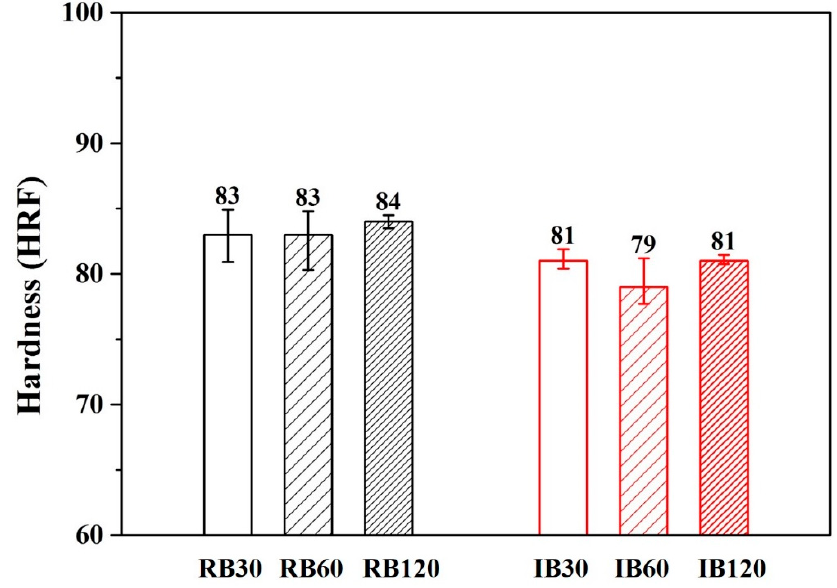
Figure 8. Hardness of various heat-treated forging B specimens.